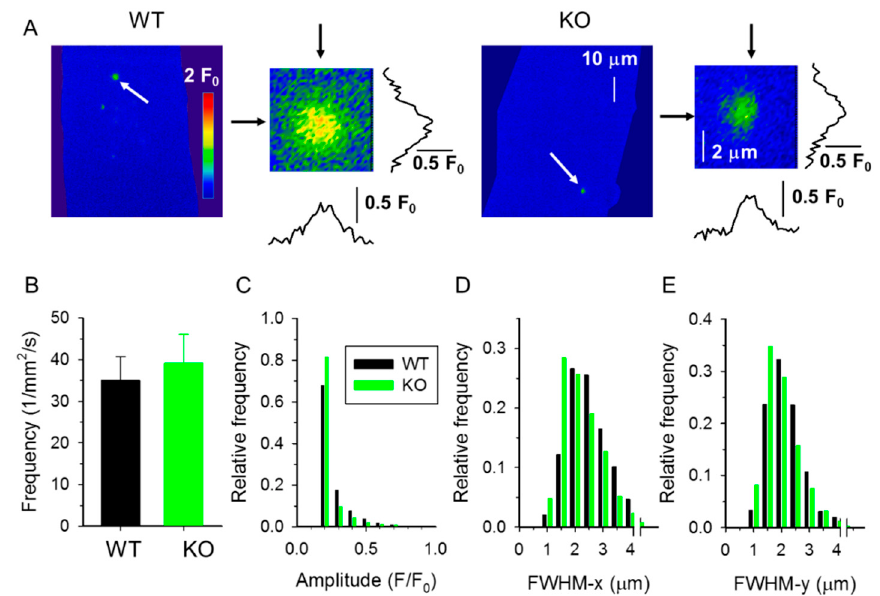
Figure 6. Parameters of Ca 2 + release events in 10-month-old WT and sAnk1 KO mice. ( A ) A single XY image of normalized fluorescence (F / F 0 ). The images were obtained as described for Figure 5A. ( B – E ) Pooled data for CREs frequency ( B ), amplitude ( C ), and FWHM in x ( D ) and in y ( E ) directions for WT (number of events, n = 1063) and KO ( n = 1646) fibers.